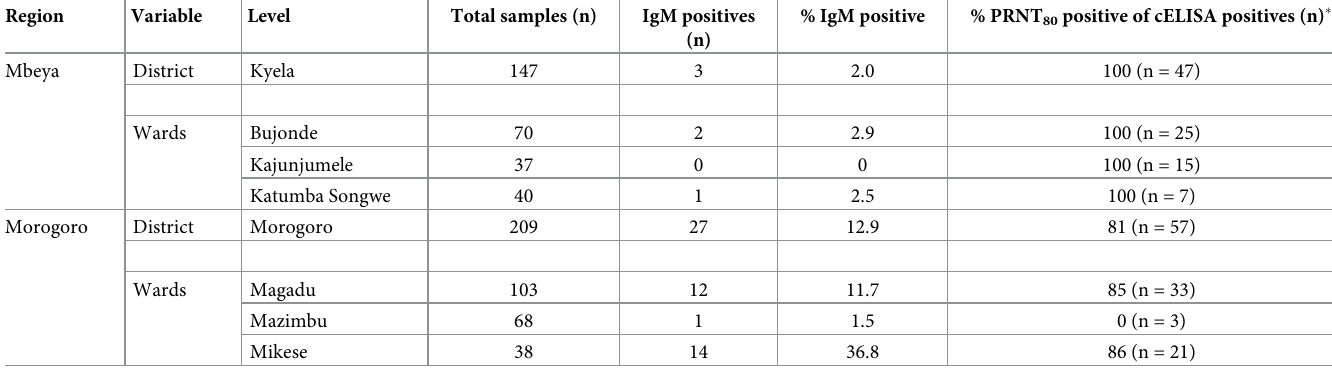
respectively. In the Morogoro district, the RVFV IgM seroprevalence was 11.7% (12/103), 1.5% (1/68) and 36.8% (14/38) for Magadu, Mazimbu and Mikese wards respectively while in Kyela district, the IgM seroprevalence was 2.9% (2/70), 0% (0/37) and 2.5% (1/40) in Bujonde, Kajunjumele and Katumba Songwe wards respectively (Table 3). Positive samples by cELISA were also analyzed for presence of RVFV neutralising antibody by the PRNT assay and 89% (93/104) of all cELISA-positive samples were PRNT-positive. 80 All (47/47) cELISA positive samples from the Kyela district contained RVFV neutralising anti- body, while 81% (46/57) of the samples from Morogoro district had neutralising antibody. Antibody titres ranged from 1:10 to 1:10240 and above (S1 Table). Some ELISA positive cattle samples collected from wards in Morogoro district gave titers below 1:10 which was consid- ered negative.